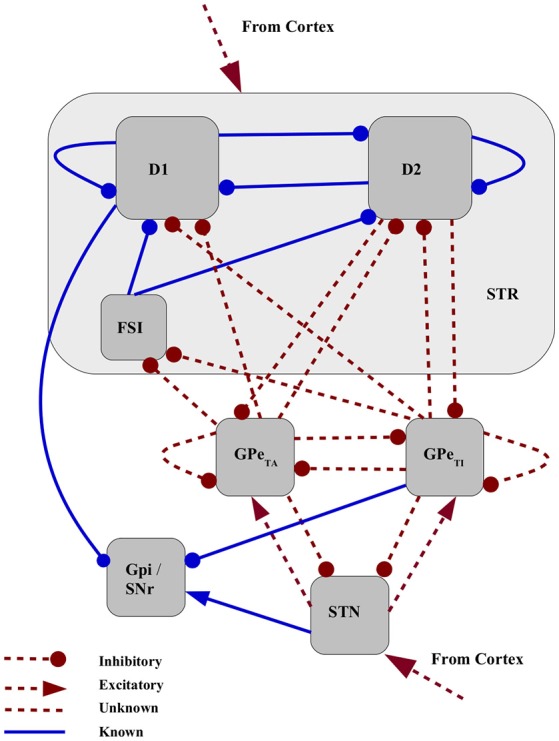
Network schematic for mean field model of basal ganglia. Connectivity strengths that can be estimated from experimental data are are fixed in this study shown as blue solid lines. The strengths of red dashed projections are considered to be free parameters in the model.